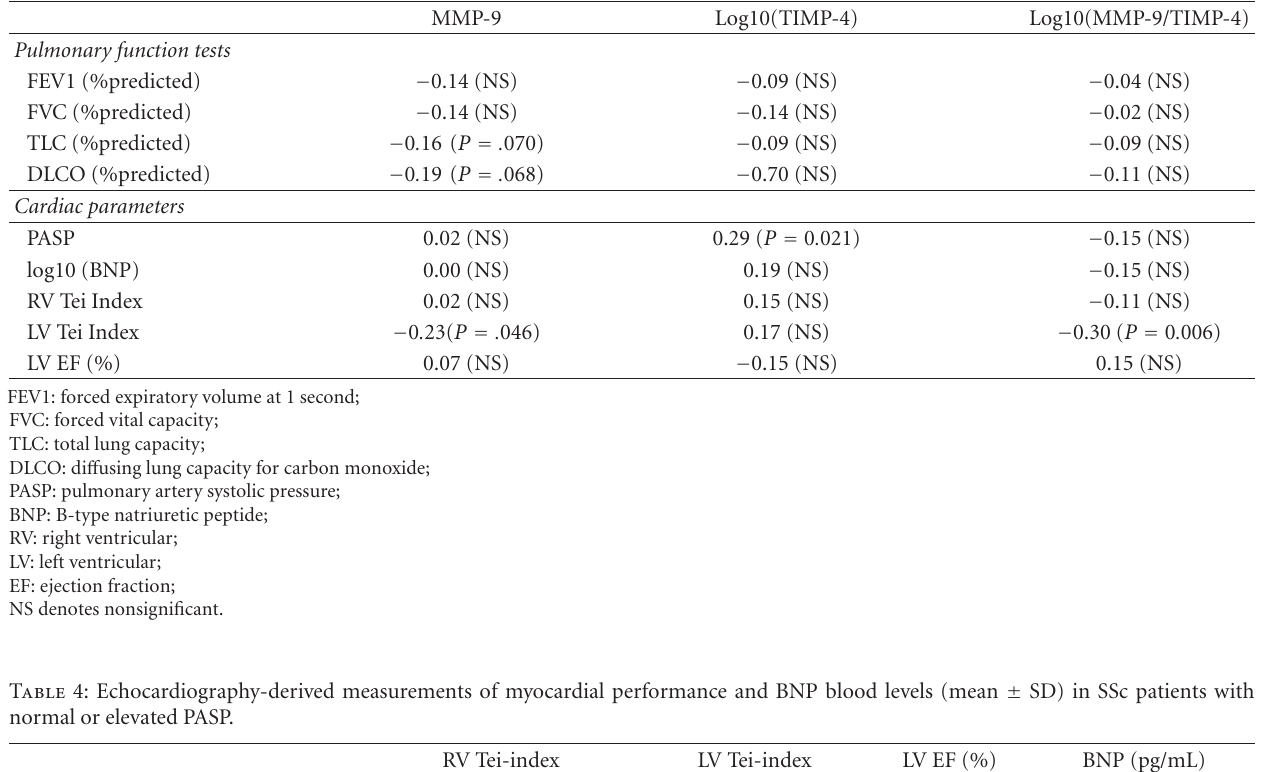
Table 3: Age-adjusted partial correlations ( r ) of MMP-9, TIMP-4 and their ratio with respiratory and cardiac indicators in 106 patients with systemic sclerosis. Levels of significance are shown in parentheses.